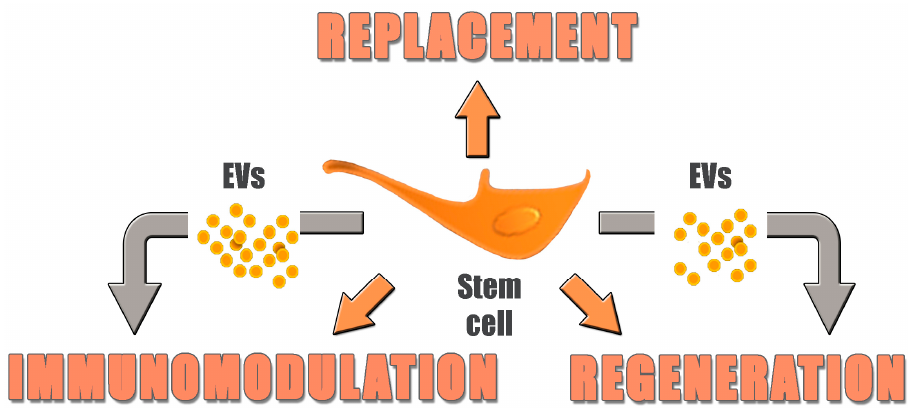
Figure 2. Stem cells vs. extracellular vesicles (EVs) as therapeutic tools. EVs seem to reproduce many of the regenerative and immunomodulatory effects of their cells of origin, but cells are still required to replace total loss of tissues.